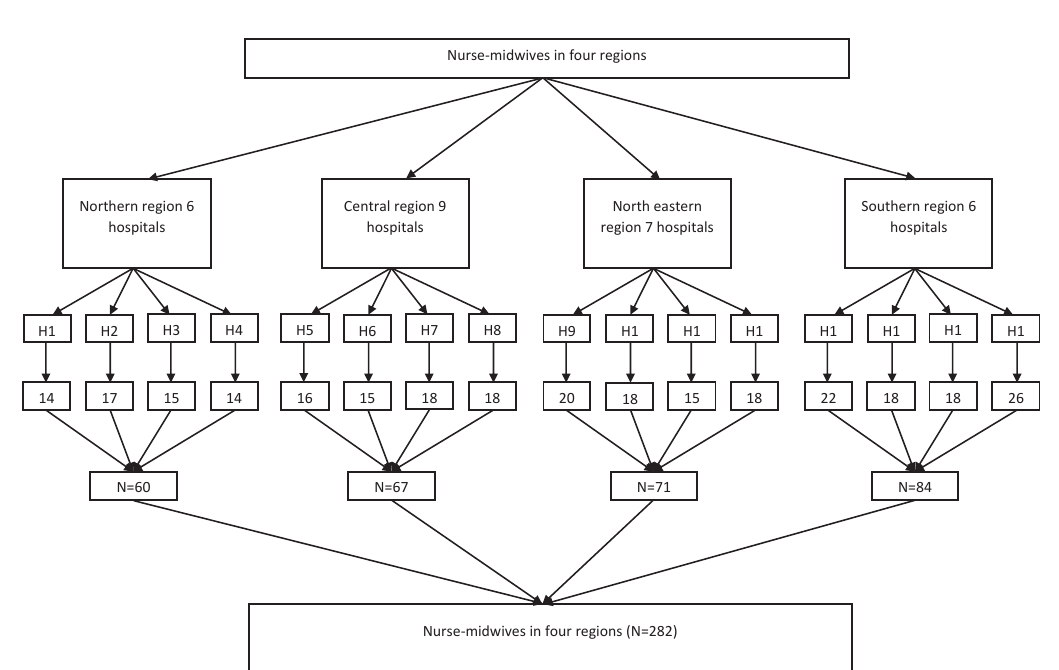
Figure 2. Random sampling of hospitals and convenience sampling of participants by head nurses (H).